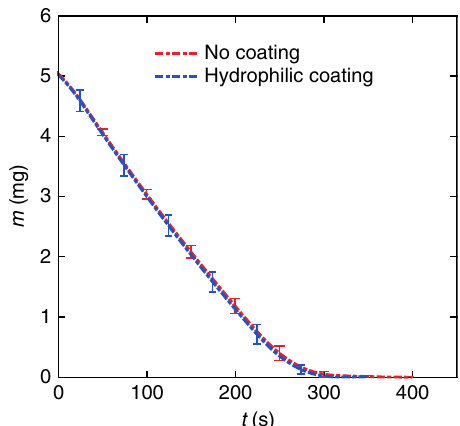
Figure 5 | Effect of hydrophilic coating on evaporation of ethanol drops. Instantaneous mass of an ethanol drop with a circular contact area demonstrating that the hydrophilic coating did not have any effect in the evaporation kinetics of the sessile drops under